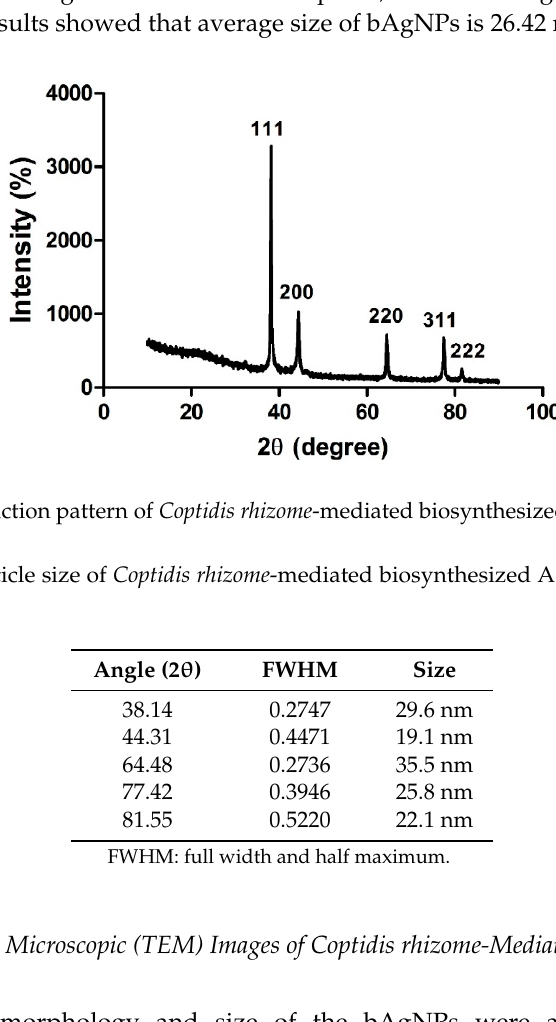
Table 1. Average particle size of Coptidis rhizome- mediated biosynthesized AgNPs calculated using Scherrer’s equation.